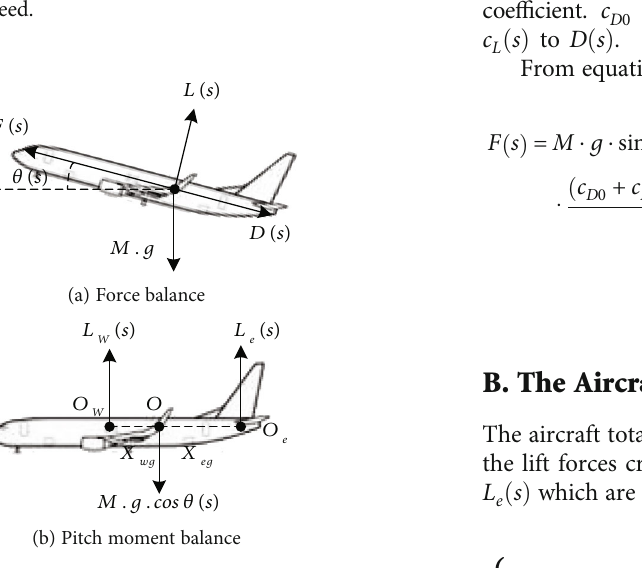
Figure 11: The aircraft force and pitch moment balance